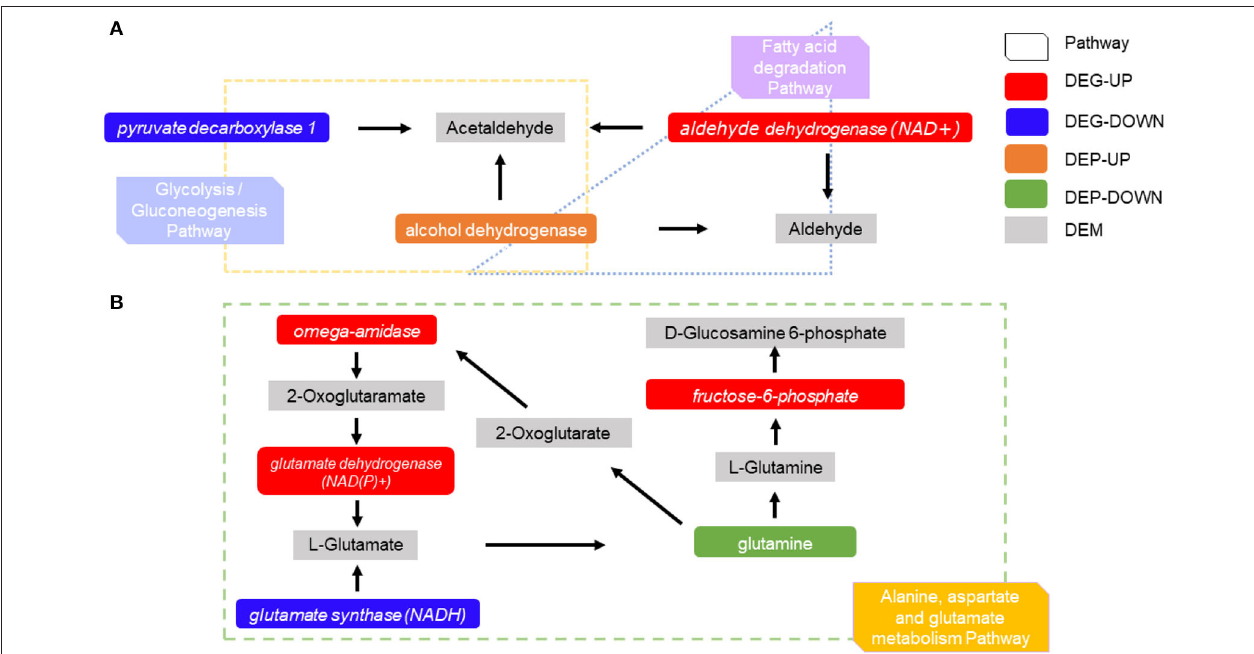
FIGURE 8 | Differentially expressed proteins differentially expressed metabolites, and DEGs are regulated in the pathway. (A) The interaction between related DEGs differentially expressed proteins, and differentially expressed metabolites in the fatty acid degradation pathway and glycolysis/gluconeogenesis pathway. (B) The interaction between related DEGs has differentially expressed proteins, and differentially expressed metabolites in alanine, aspartate, and glutamate metabolism